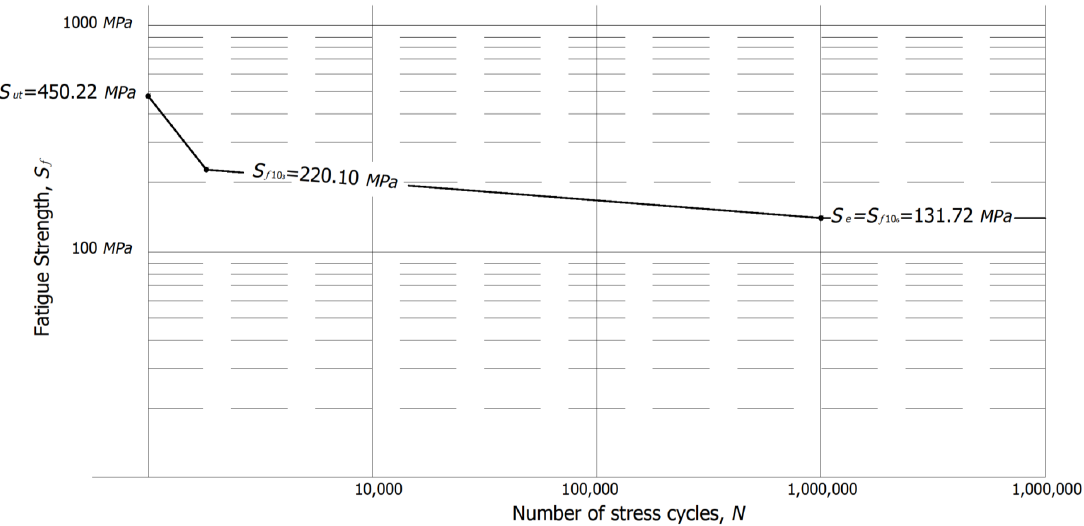
Figure 2. S-N diagram for application case.